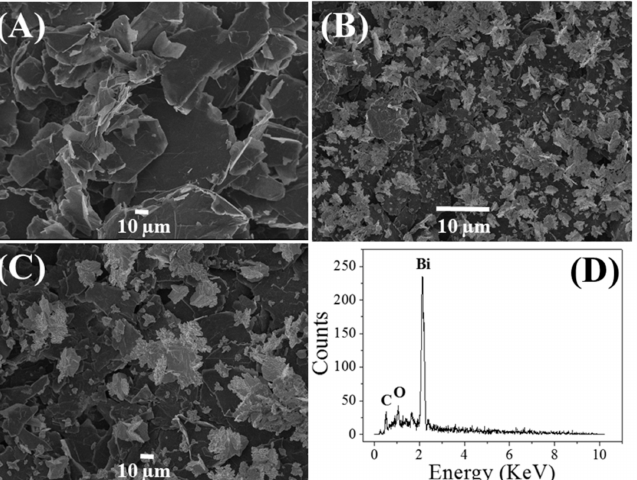
Figure 1. SEM images of reduced graphene oxide ( A ); bismuth on reduced graphene oxide ( B , C ); and EDX ( D ).